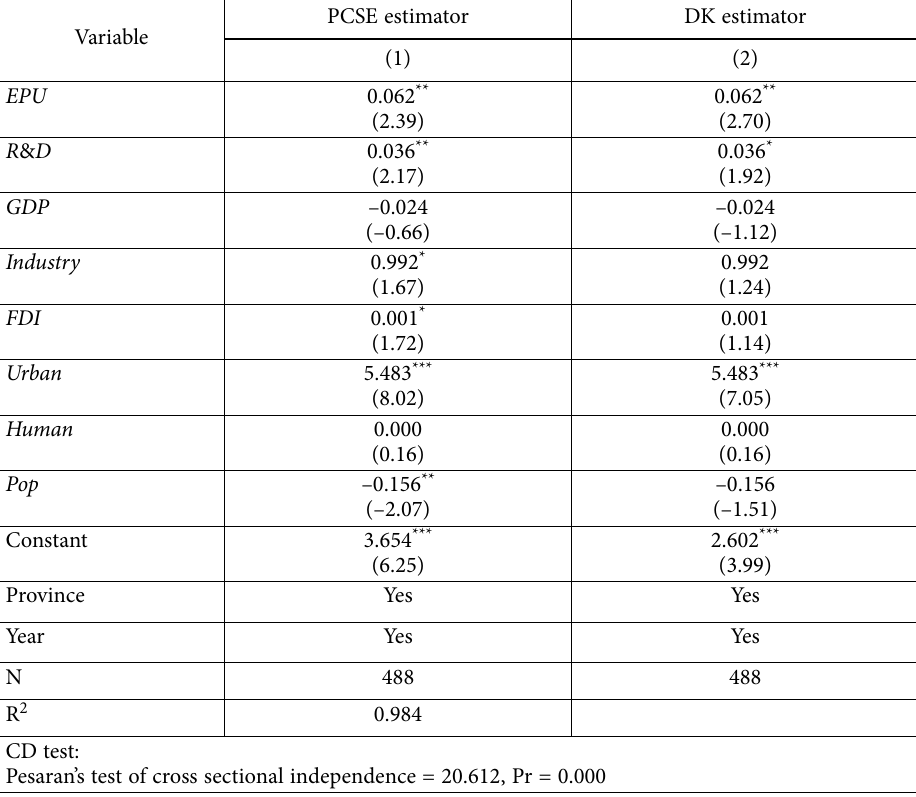
Table 7. Robustness tests: considering cross-sectional dependence